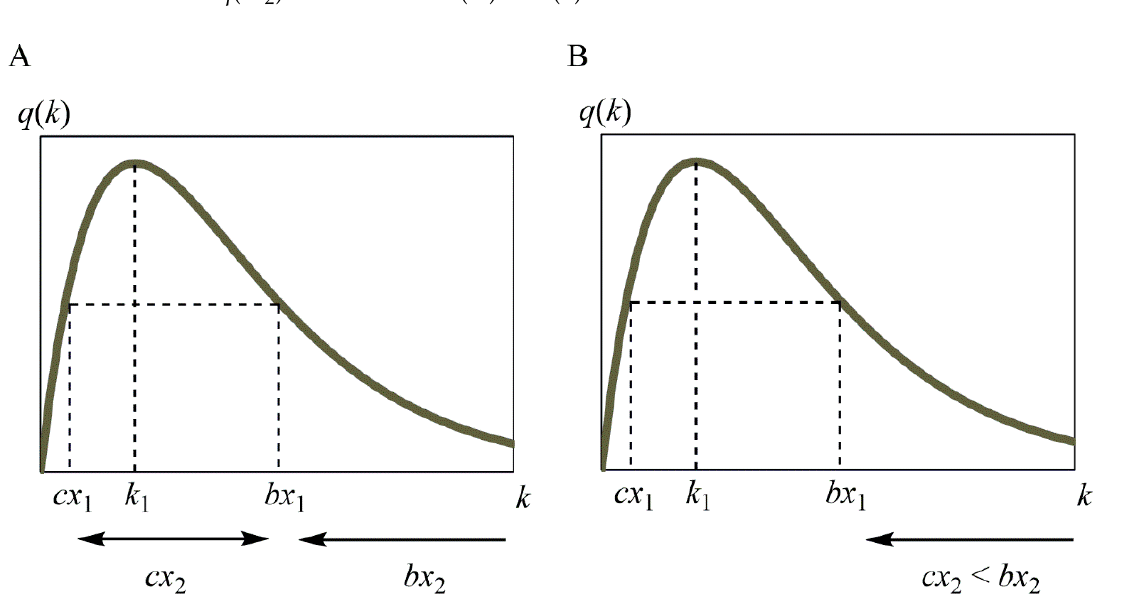
Table 6. The derivative sign chart of R ( x ).